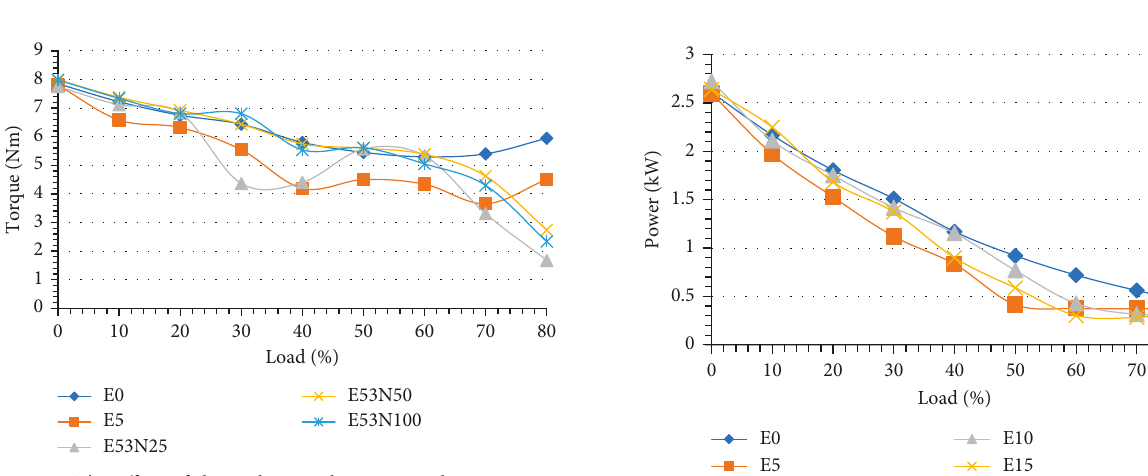
Figure 6: The effect of three elemental nanoparticles amounts on engine torque.